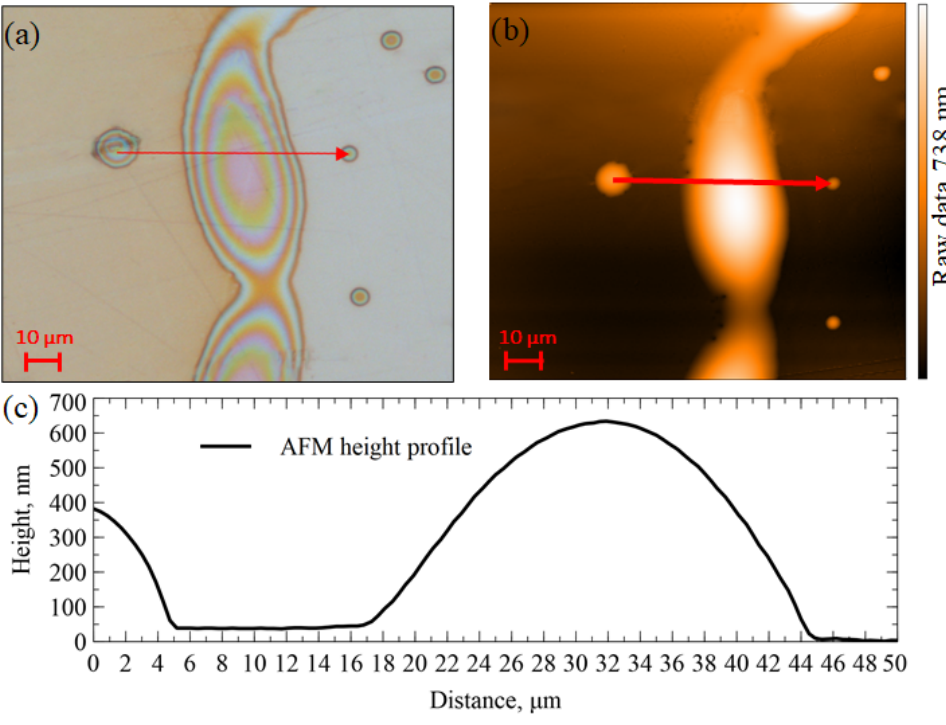
Figure 7. Illustration of AFM calibration of the thickness information carried by the light interference in optical microscopy images: ( a ) optical microscopy image of the PEI dot edge with a profile line marker; ( b ) AFM height map of the same area with the corresponding profile line marker; ( c ) AFM height profile along the line indicated in the ( a , b ) parts of the